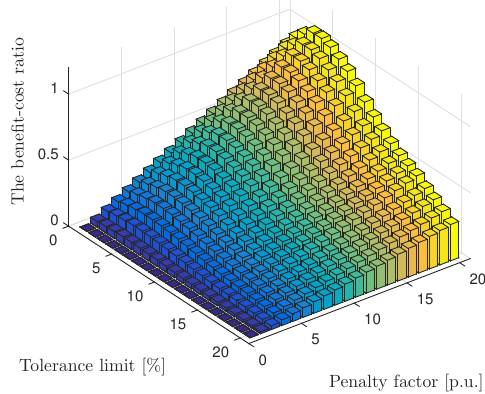
Figure 15. The benefit-cost ratio of the ANN scheme with a power capacity of 10%.